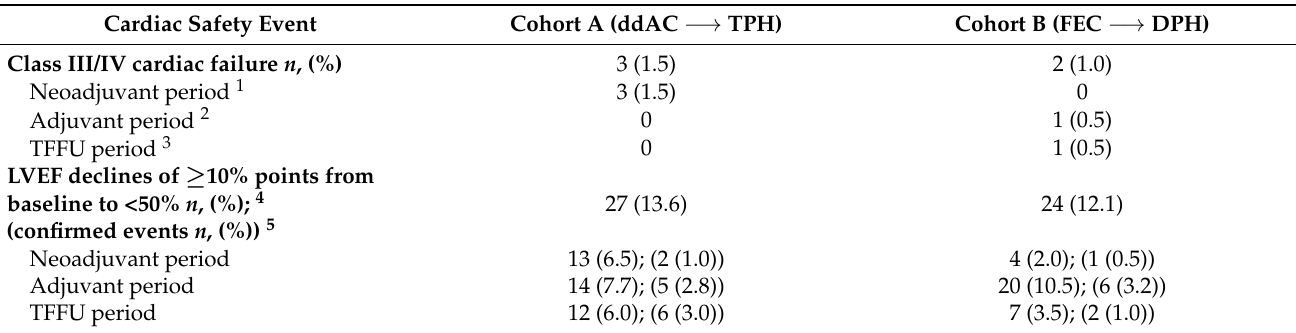
Table 1. Cardiac safety across all study